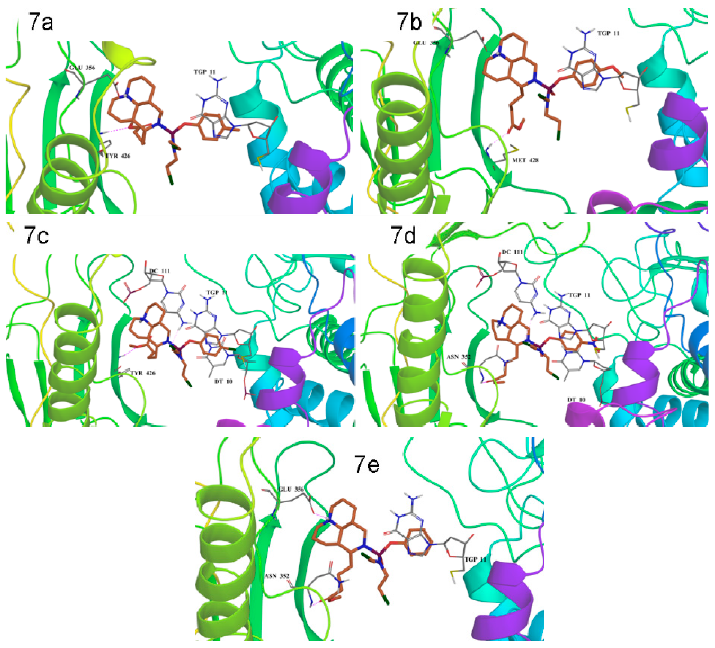
Figure 5. Schematic representation of the proposed binding mode for 7a ‒ 7e with Top I-DNA (Protein Data Bank (PDB) code: 1T8I).